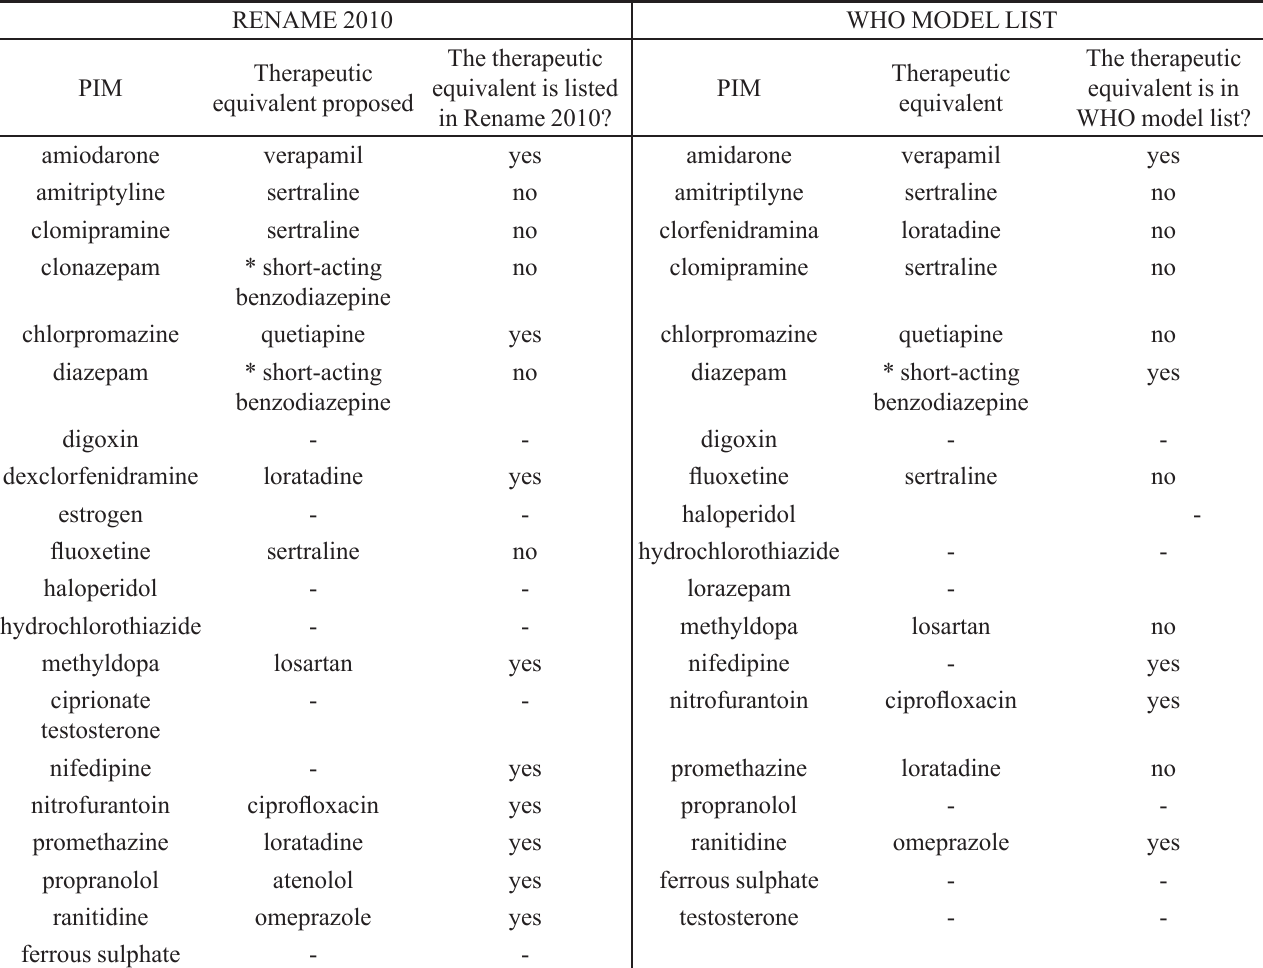
TABLE III - Potentially inappropriate medications (PIM) for elderly people listed by the instruments identified in Paho, Lilacs and Pubmed databases, during Februrary and March 2010, which are present in the Brazilian list of essential medicines (RENAME 2010) and in the 16 th WHO Model List of Essential Drugs, and their possible equivalent